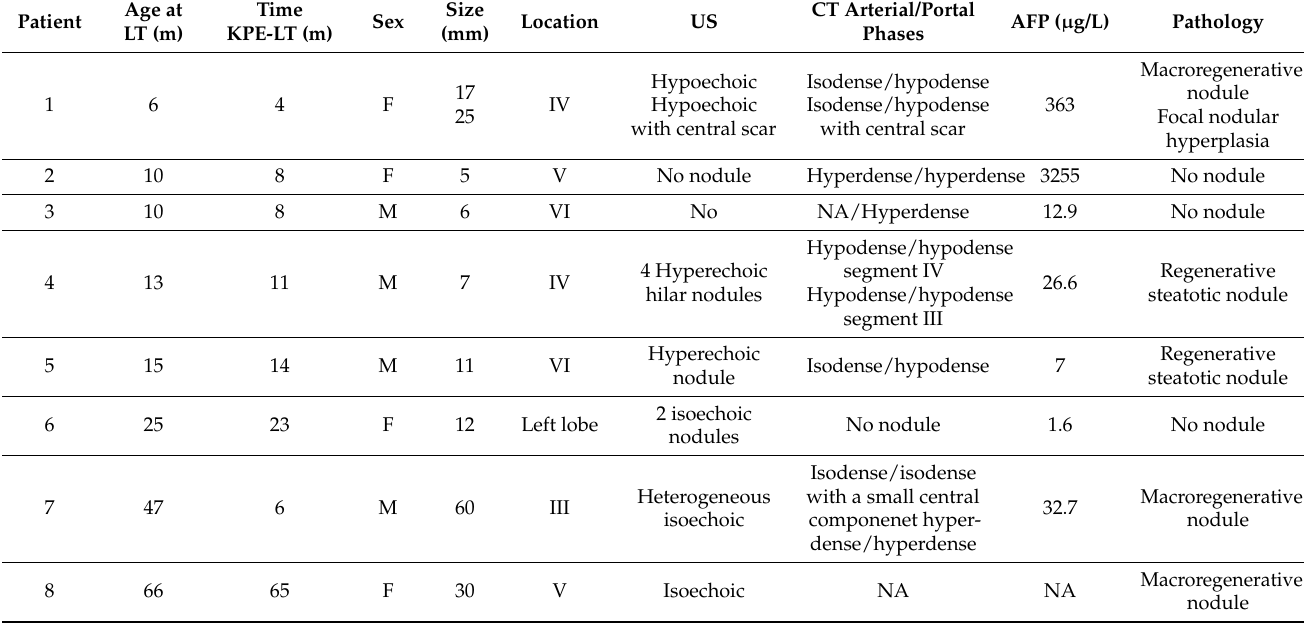
Table 1. Clinical, biological and imaging characteristics of patients with nodules on pretransplant imaging . LT, liver transplantation; US, ultrasound; CT, computed tomography; KPE, Kasai hepatopor- toenterostomy; F, female; M, male; m, months; NA, not